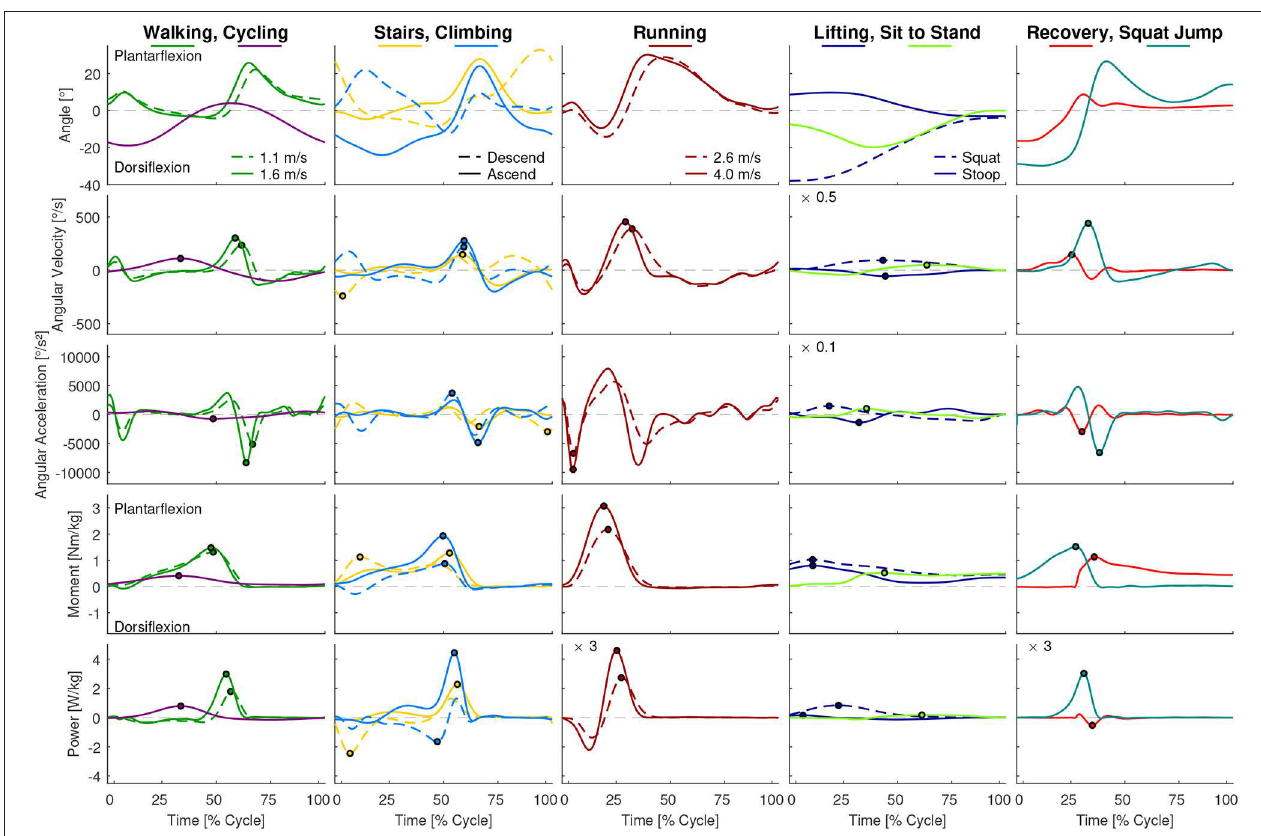
FIGURE 9 | Ankle angle, angular velocity, angular acceleration, moment and power for all analyzed movements. Dots indicate the maxima used for Figures 2 , 4 . For visibility some of the graphs were scaled with a factor, which is located at the top left of these graphs. For example, a scaling factor of 0.1 indicates that the y-axis must be multiplied by